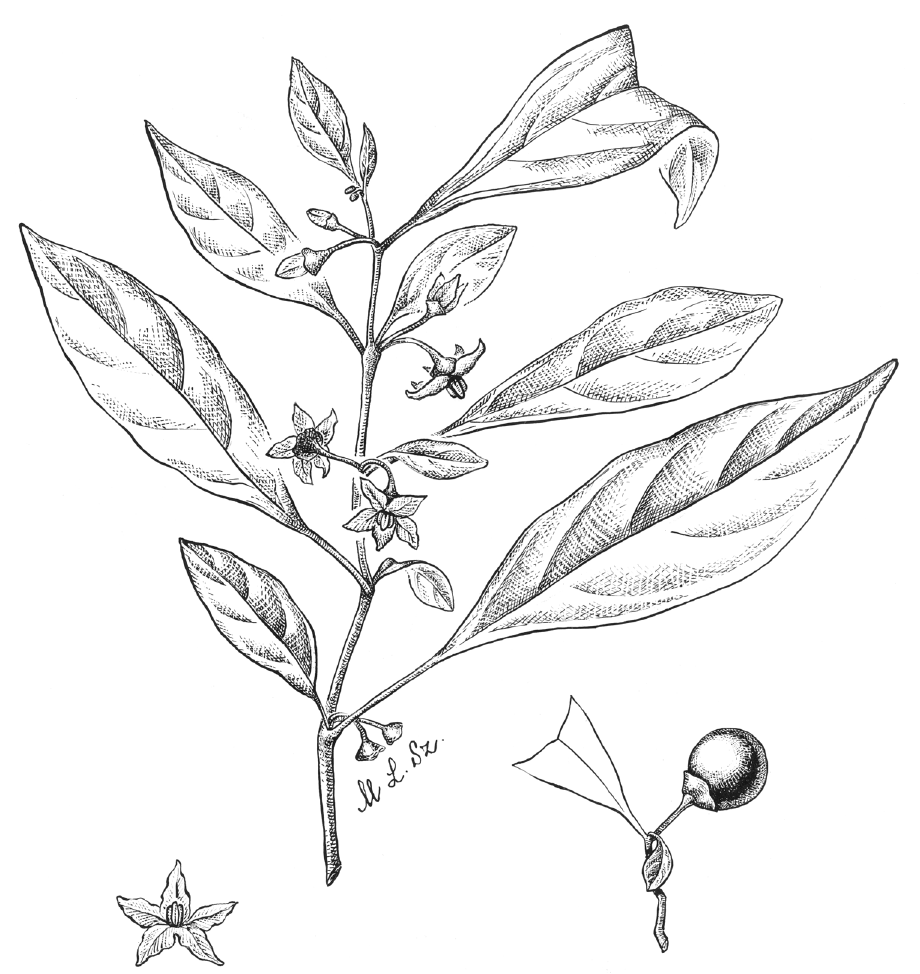
Figure 7. Lycianthes belensis (Merr. & L.M.Perry) A.R.Bean. Drawing by M.L. Szent-Ivany, first pub- lished in Symon (1985: fig. 9, as S. belense Merr. & L.M.Perry). Courtesy of the Board of the Botanic Gardens and State Herbarium (Adelaide, South Australia), reproduced with